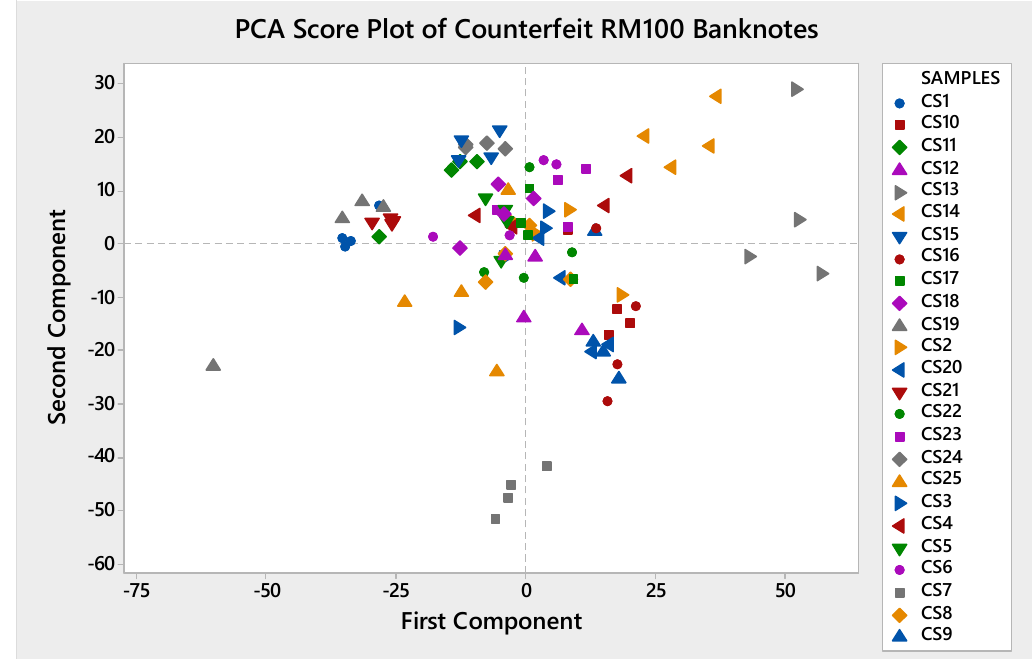
Figure 8. The PCA score plot of counterfeit (CS) RM100 banknotes samples.